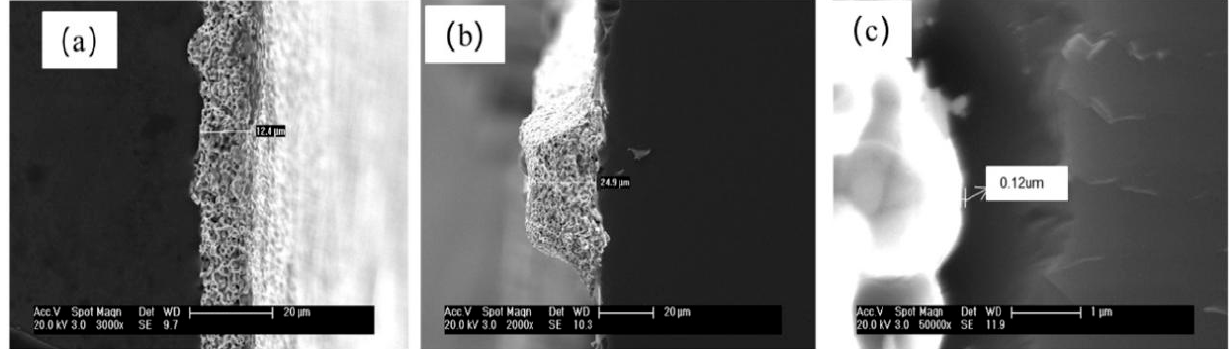
Figure 5. SEM images of ( a ) front busbar, ( b ) front finger, and ( c ) Ag-Si alloy.